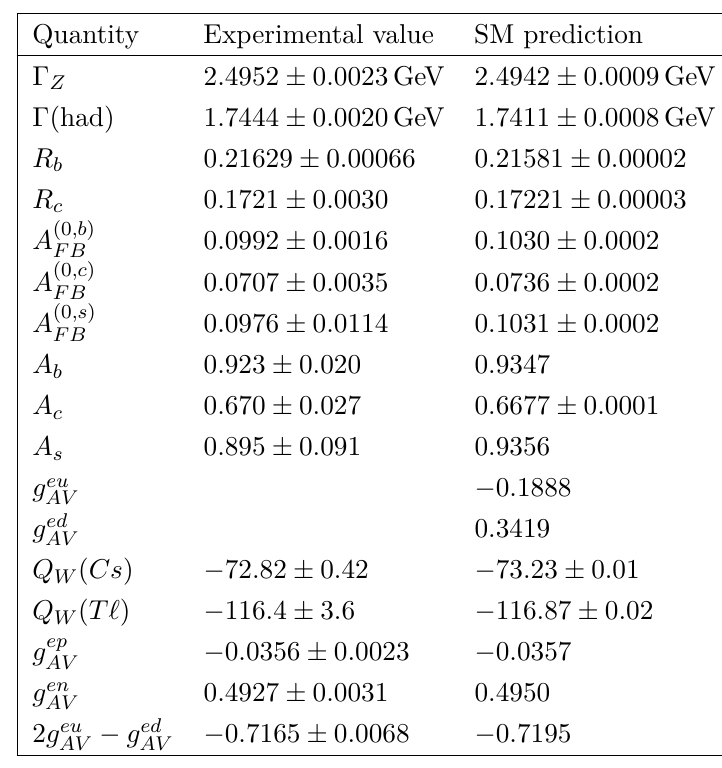
Table 5 . Values of interest from Particle Data Group